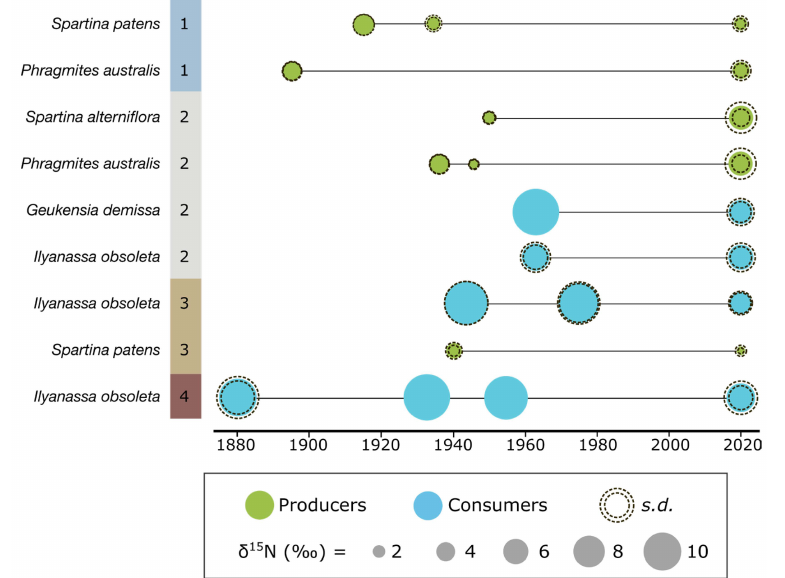
Figure 8. Comparison of δ 15 N in historic and modern samples of producers (green) and consumers (blue), by zone (1 to 4). Shell-bound δ 15 N was measured for historic consumer samples. Dashed circles indicate mean δ 15 N ± standard deviation, derived from technical replicates (historic specimens) or biological replicates (modern